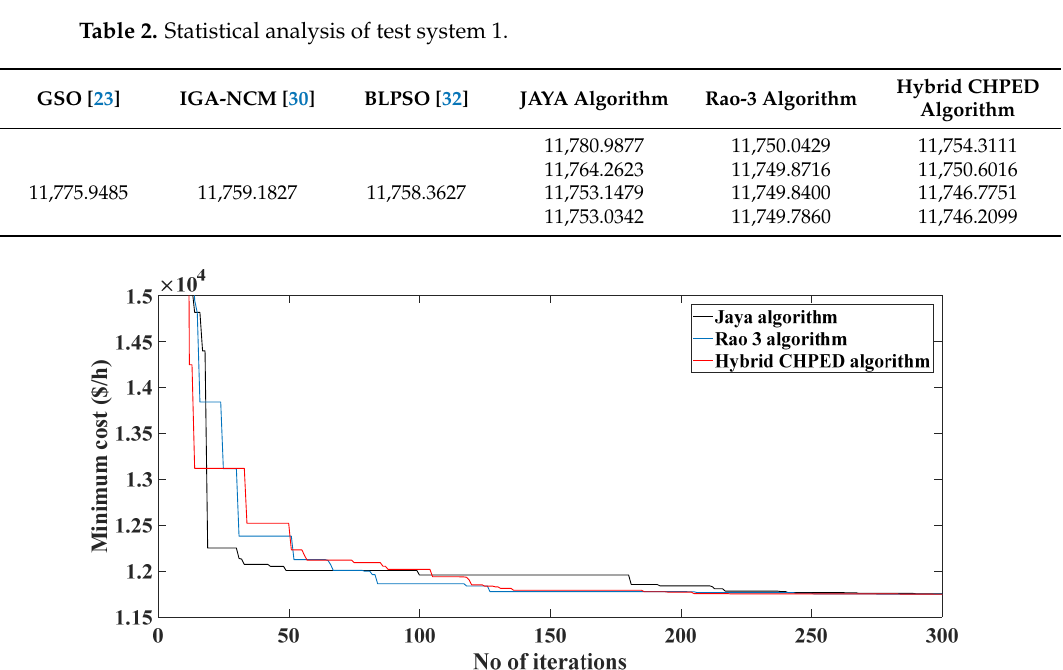
Table 1. Optimised values of the power-heat production of test system 1 .